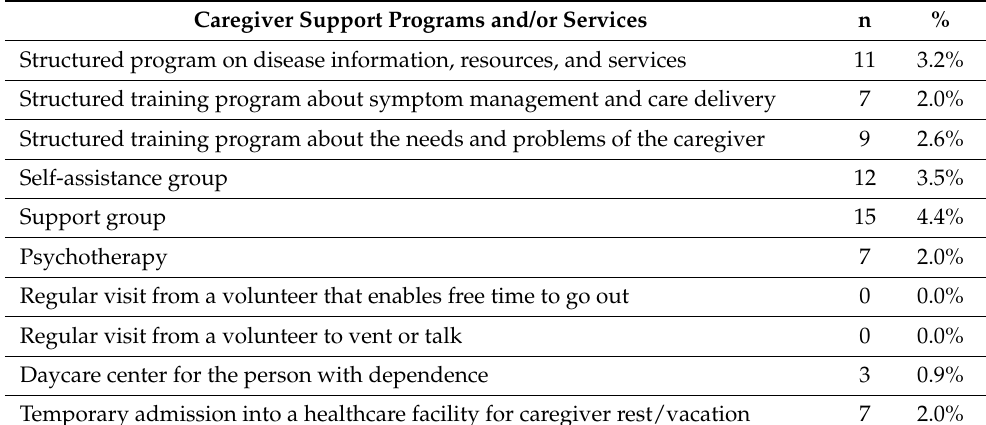
Figure 2. Caregiver access to support programs. Table 4. Support programs or services with caregiver access and participation.